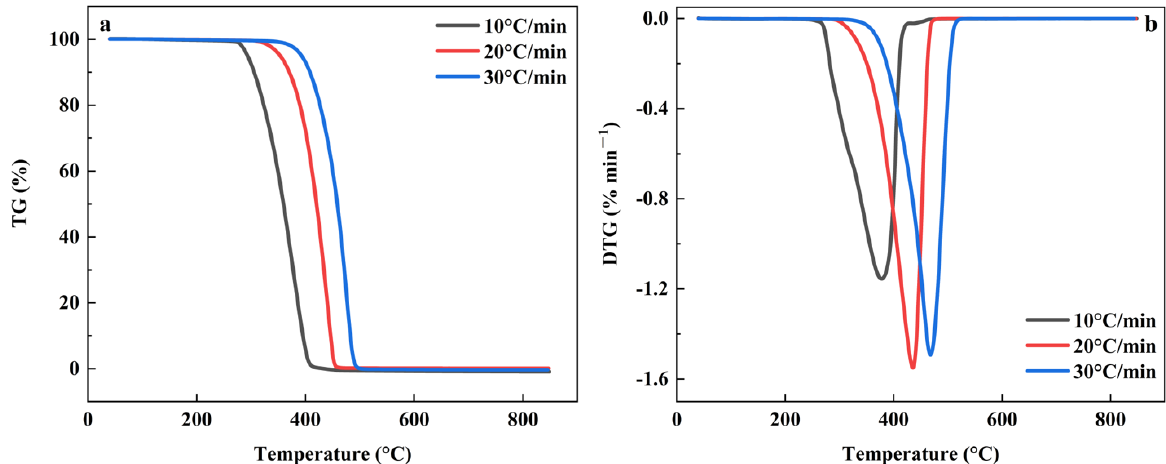
Figure 4. The TG-DTG curves for PP pyrolysis at different heating rates. (a) The TG curve of PP; (b) The DTG curve of PP.